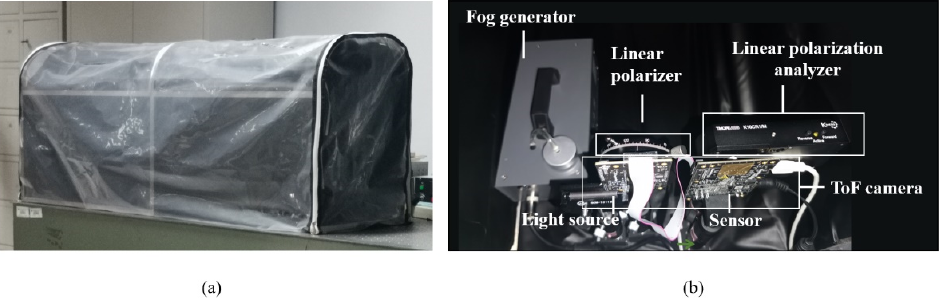
Figure 7. Experimental environment for polarization phasor imaging. ( a ) Fog chamber. Experiments with fog are conducted in this fog chamber. ( b ) Experimental setups.